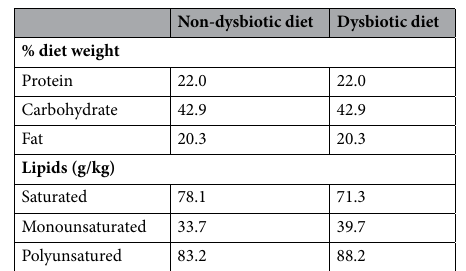
Table 1. Composition of the diets used in the